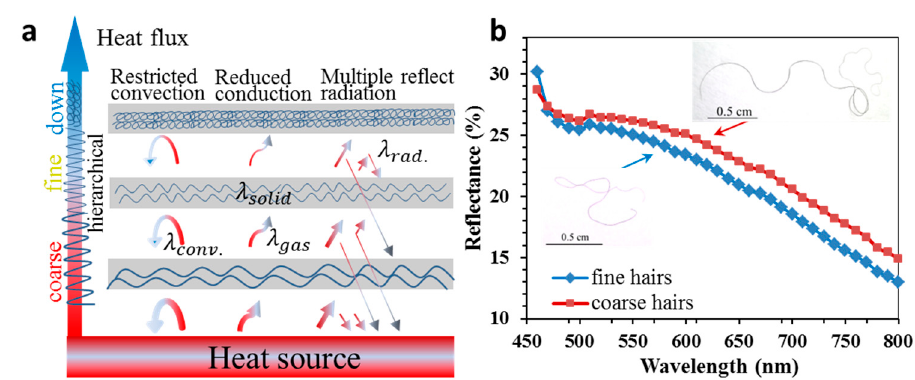
Figure 7. Thermal insulation of yak hairs. ( a ) Schematic illustration of thermal conductivity, convection, and radiation of yak hairs from coarse to fine crimps; ( b ) the reflectance (including absorption) measurement of visible to near infrared lights for coarse (diameter = 40 to 60 µ m) and fine (diameter = 20 to 40 µ m) yak hairs, using a visible- infrared spectroscopy microscope.